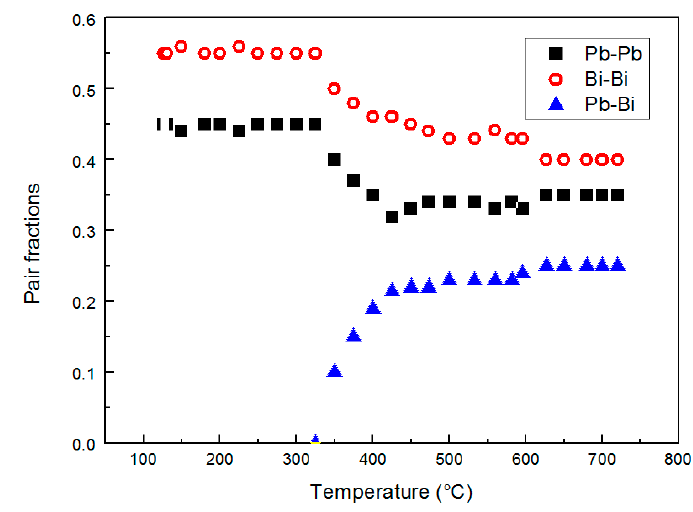
Figure 8. The relative amount of Bi–Bi, Pb–Bi and Pb–Pb pairs vs. temperature.